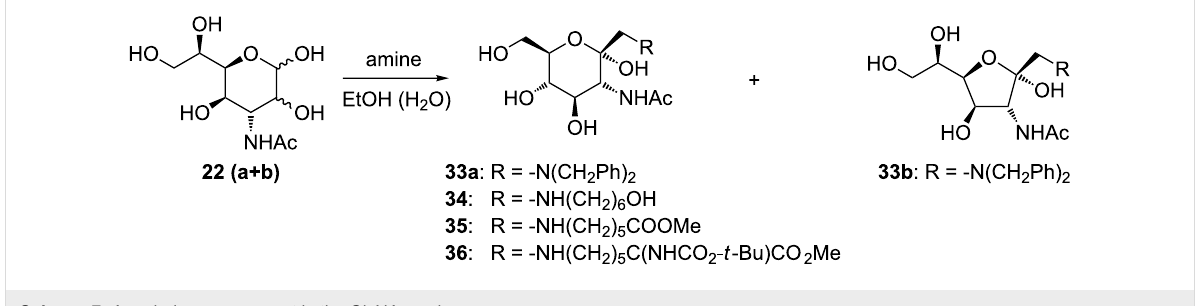
Scheme 7: Amadori rearrangement in the GlcNAc